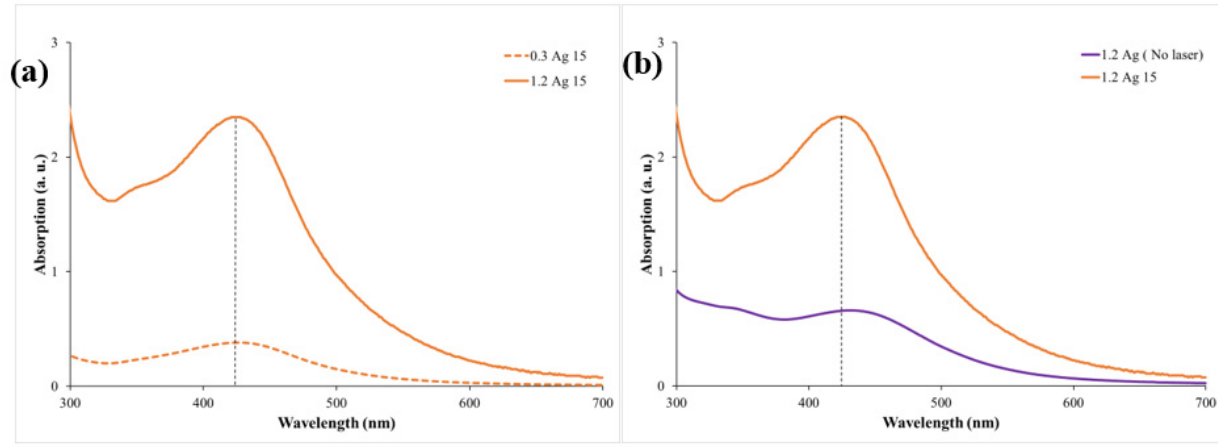
Figure 4. UV–vis absorption spectra of Ag NPs ( a ) using two concentrations of Origanum majorana extract with the same irradiation time, and ( b ) with and without laser irradiation.